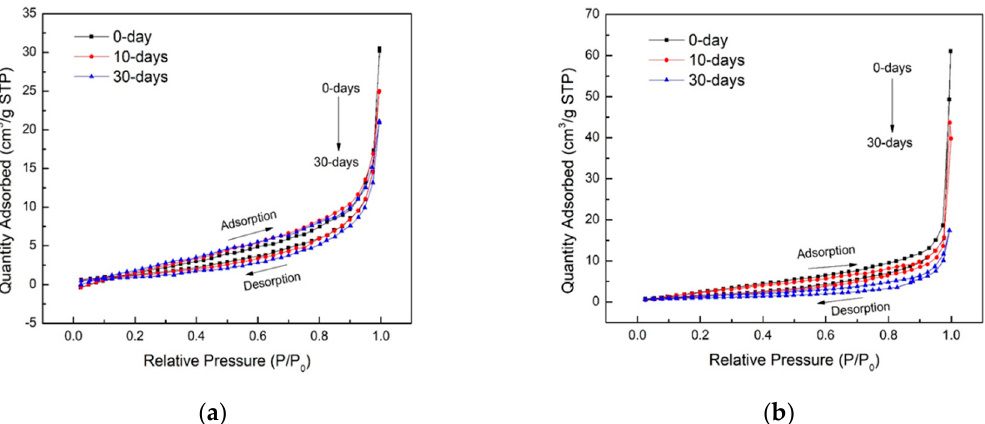
Figure 5. Isotherm curves with different Sc-CO 2 injection time. ( a ) sample at depth of 9848 ft, ( b ) sample at depth of 9850 ft.